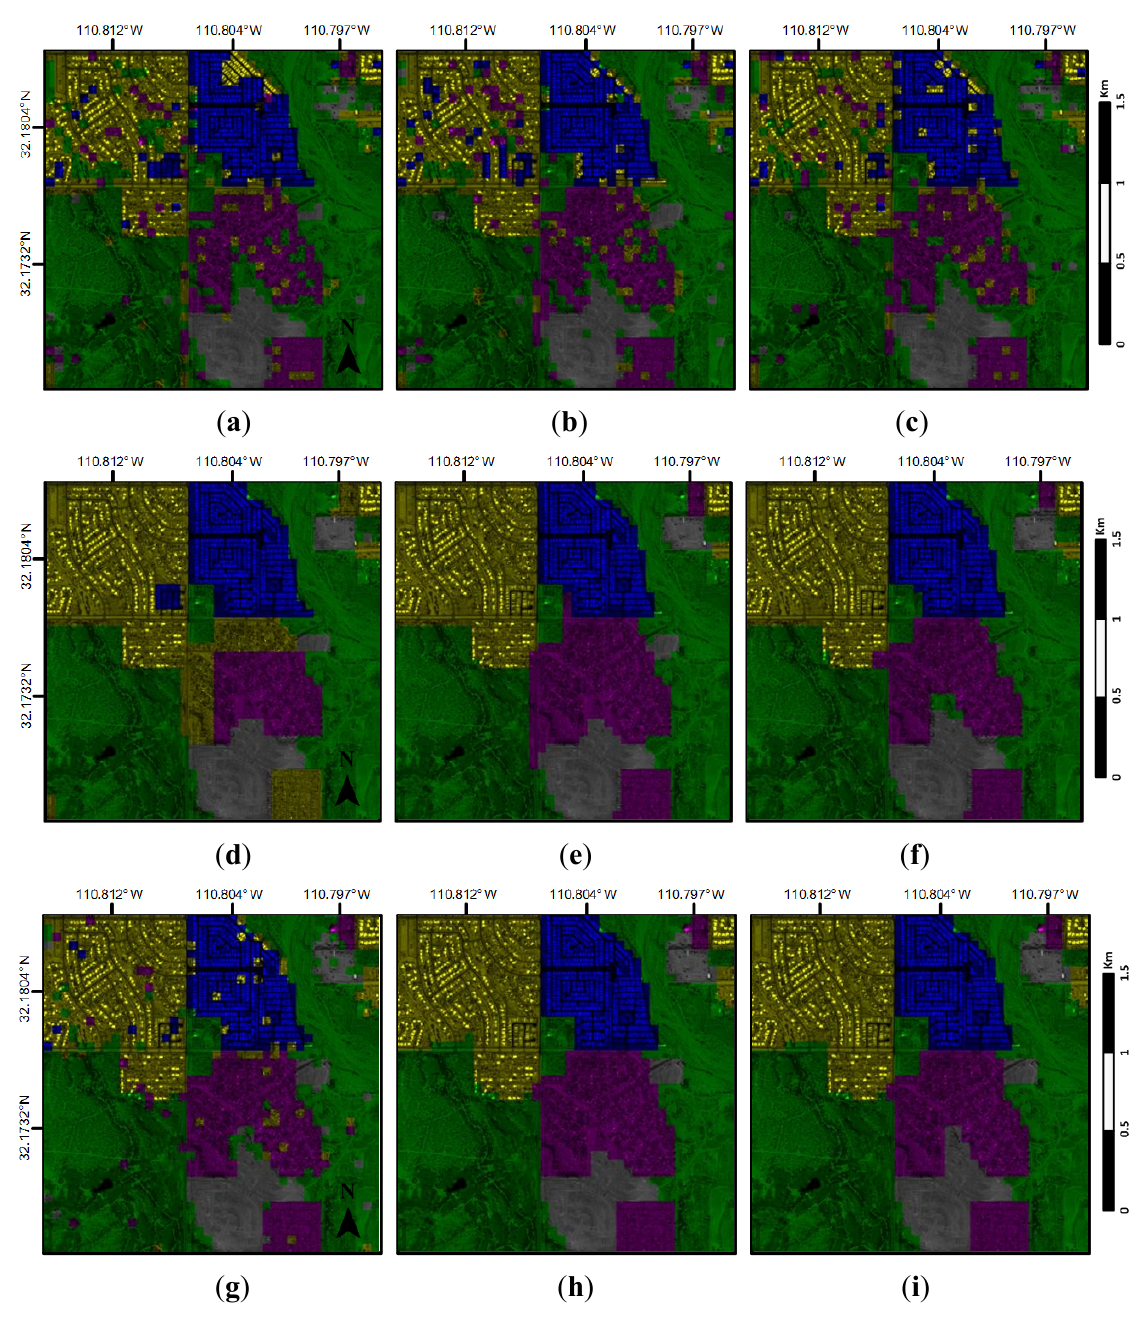
Figure 7. The annotation results of different methods for image I (number of topic is fixed to 35). ( a ) PLSA. ( b ) LDA. ( c ) MedLDA. ( d ) PLSA+CRF. ( e ) LDA+CRF. ( f )